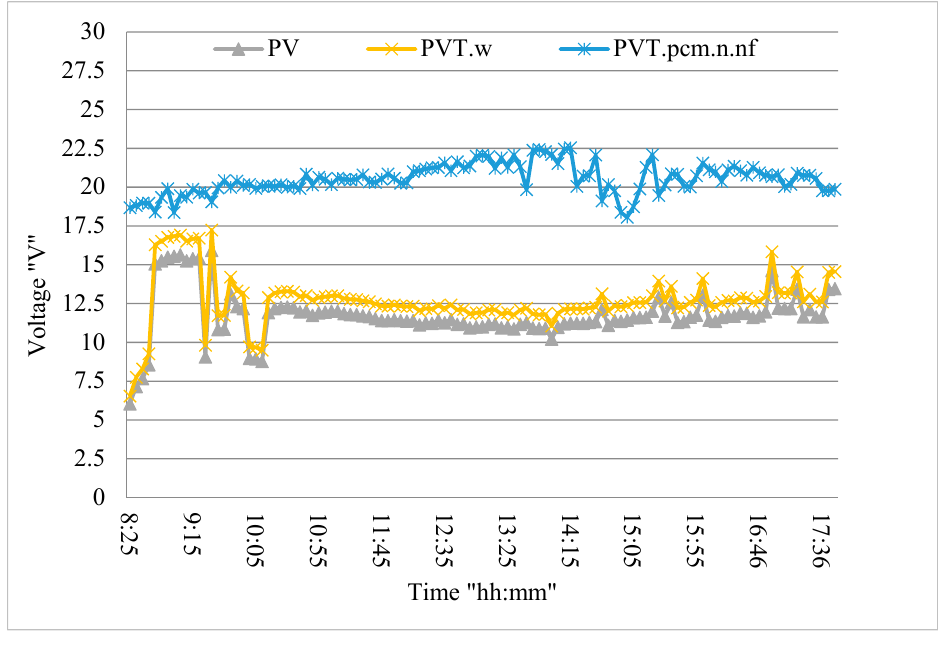
Figure 7. The tested systems’ voltage variation with time.